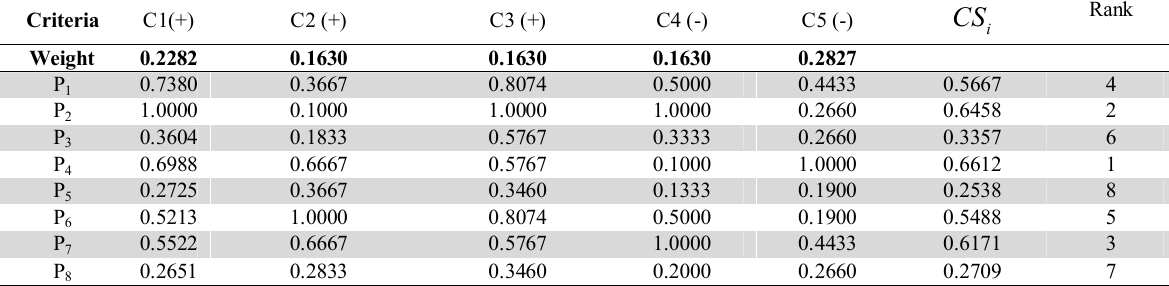
Normalized decision matrix, composite score, and rank Criteria